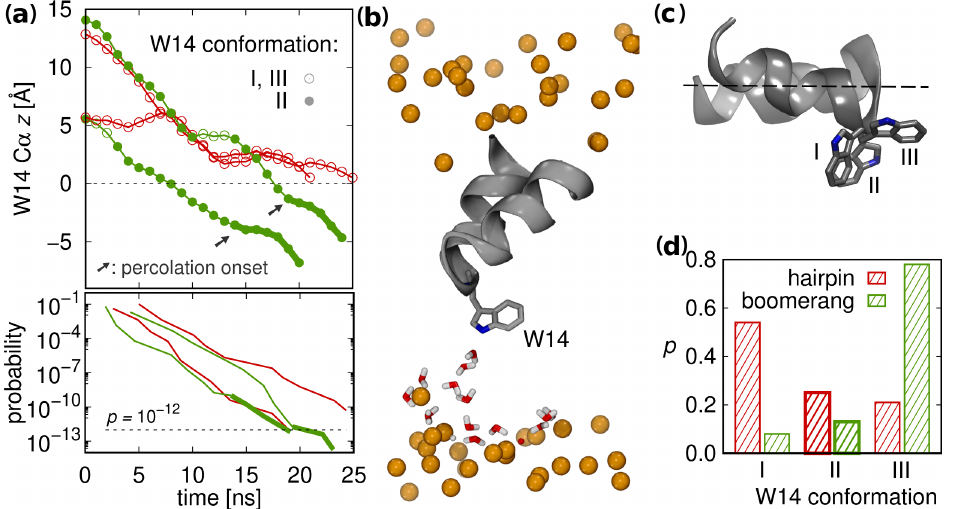
Figure 8. ( a ) (Top) Supervised insertion trajectories for two successful (green) and two unsuccessful trials (red); and (Bottom) the probability of insertion advancing along z axis. ( b ) Water wire estab- lished by interaction with W14 at percolation onset (trajectory snapshot). The water molecules within 10 Å of protein atoms and z coordinates restricted to protein-distal membrane leaflet are shown. The orange spheres represent membrane phosphate atoms. ( c ) Three main W14 conformations. ( d ) Probability distribution for finding W14A conformers in surface